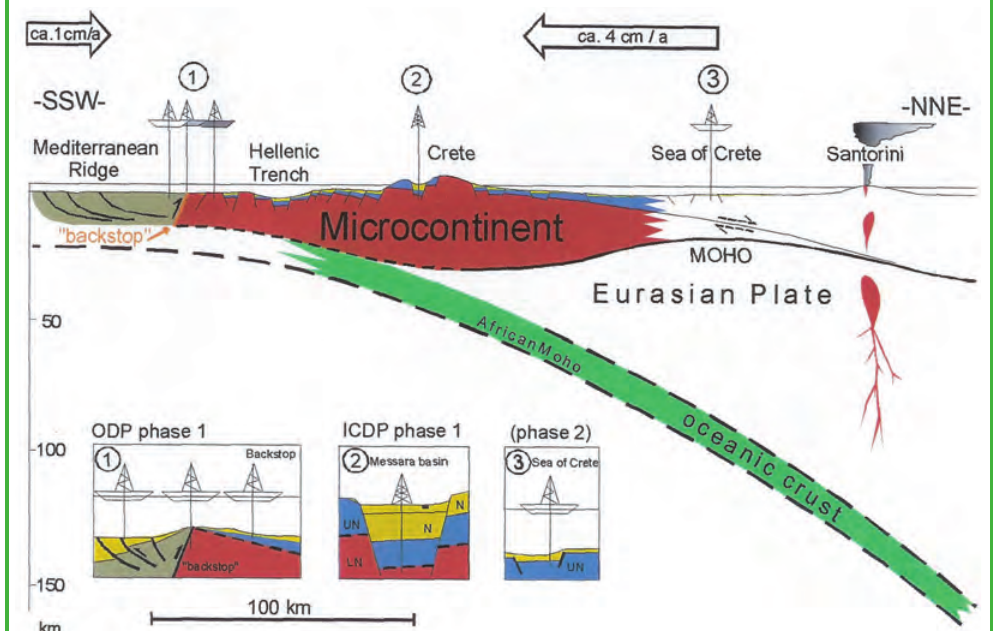
Figure 2. Transect of ICDP and marine targets for the investigation of the Hellenic Subduction Zone